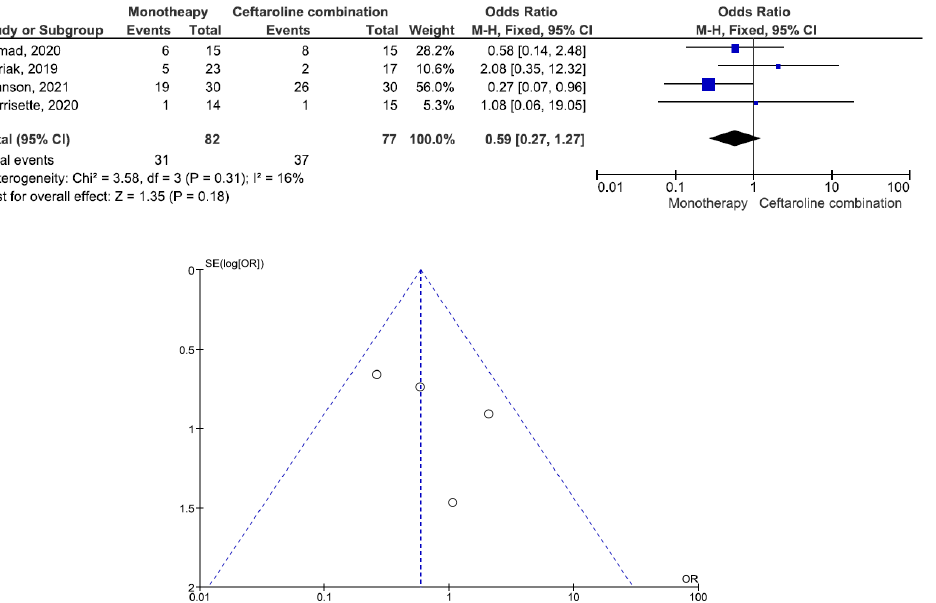
Figure 4. Forest plots and funnel plots for adverse events between monotherapy and combination therapy in the treatment of methicillin-resistant Staphylococcus aureus bacteremia.